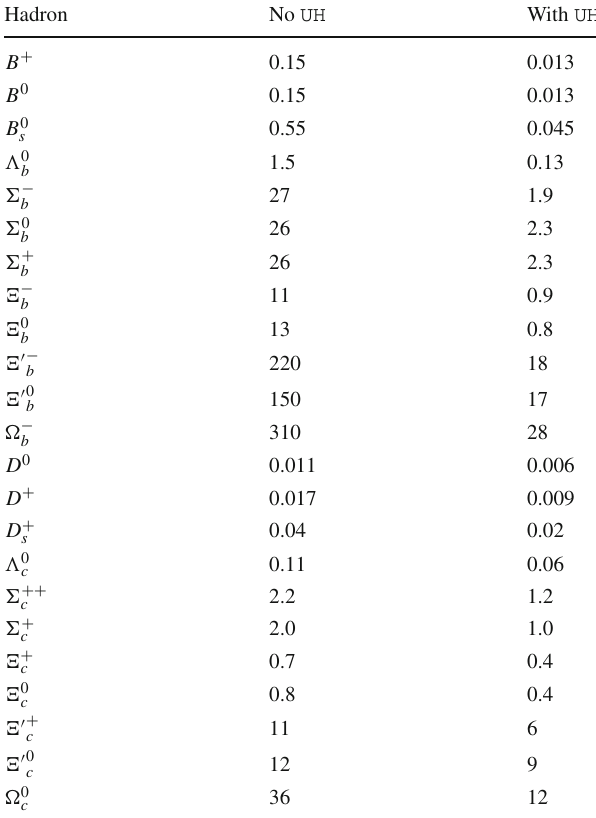
Table 1 Typical generation times in seconds for single-heavy hadrons with and without the Userhooks ( UH ) described in the text. The tests are performed using the Simple Shower model. The vetoes are imposed with ˆ p T cut-off scales of 4 . 0GeV / c and 1 . 5GeV / c for the b ¯ b and c ¯ c samples, respectively. Due to the size of the generated samples the uncertainty in the typical generation time for (cid:5) , (cid:2) and (cid:6) baryons is up to 7%, 15% and 30%, respectively. The corresponding uncertainties for the meson and (cid:7) samples are